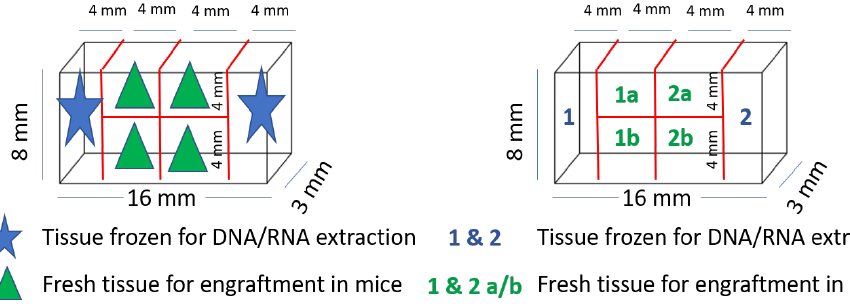
Figure 3. Tumor tissue fragmentation and naming for PDX procedure and exome sequencing.